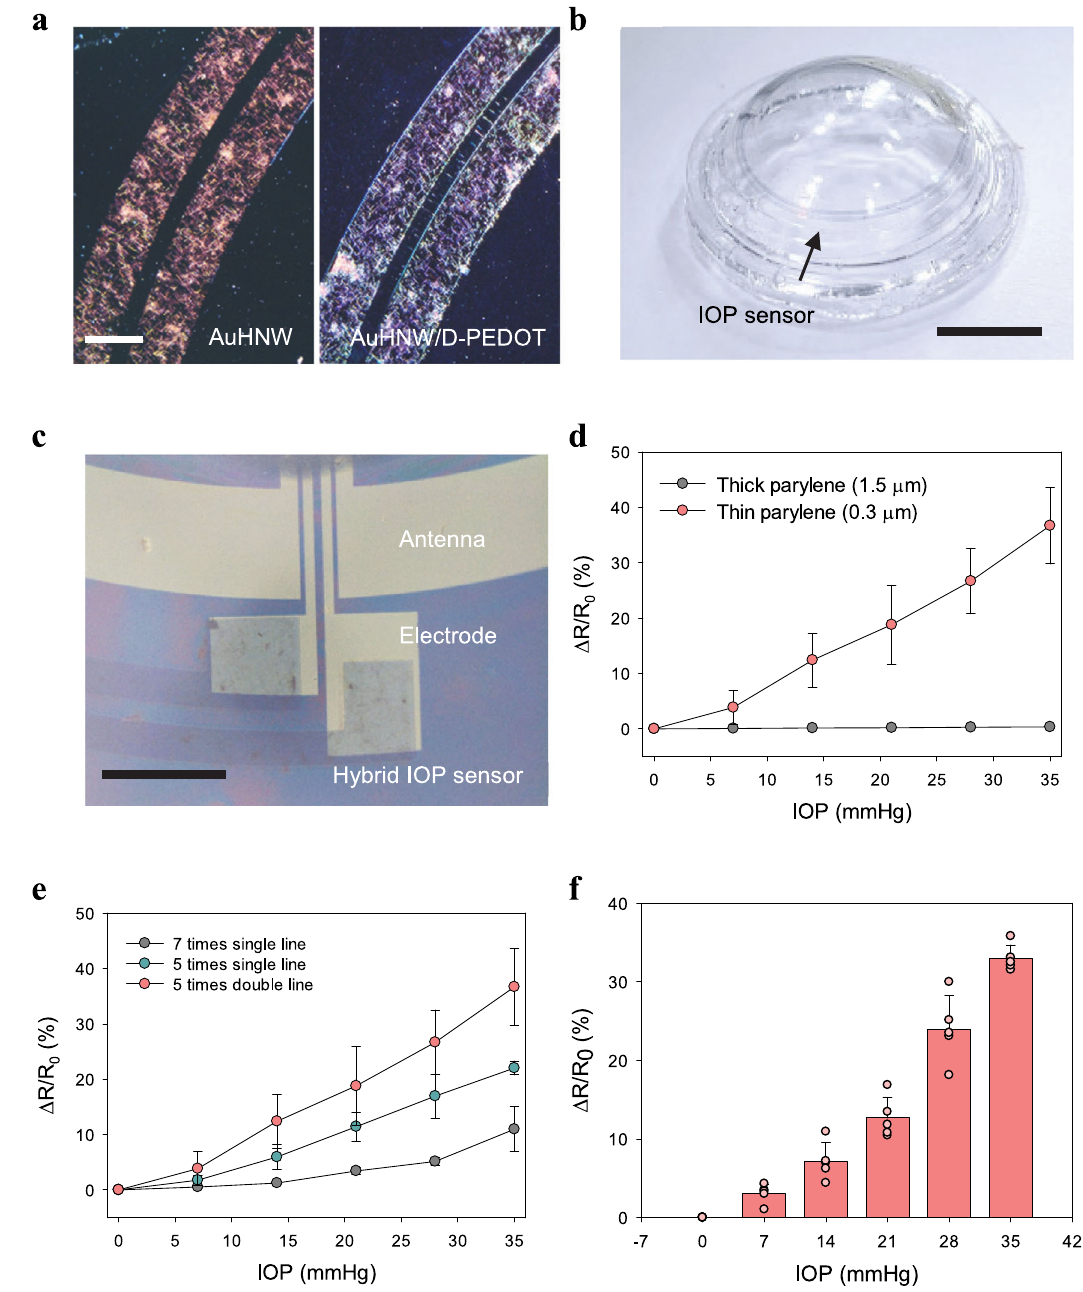
Fig.3|CharacteristicsofIOPsensor.a OMimagesofpatternedIOPsensors(scale bar, 200 μ m). b Photo-image ofanIOP sensor embedded into a smart contact lens (scale bar, 6mm). c OM image of an integrated IOP sensor and wireless circuits (scale bar, 600 μ m). The relative resistance change of IOP sensors with d